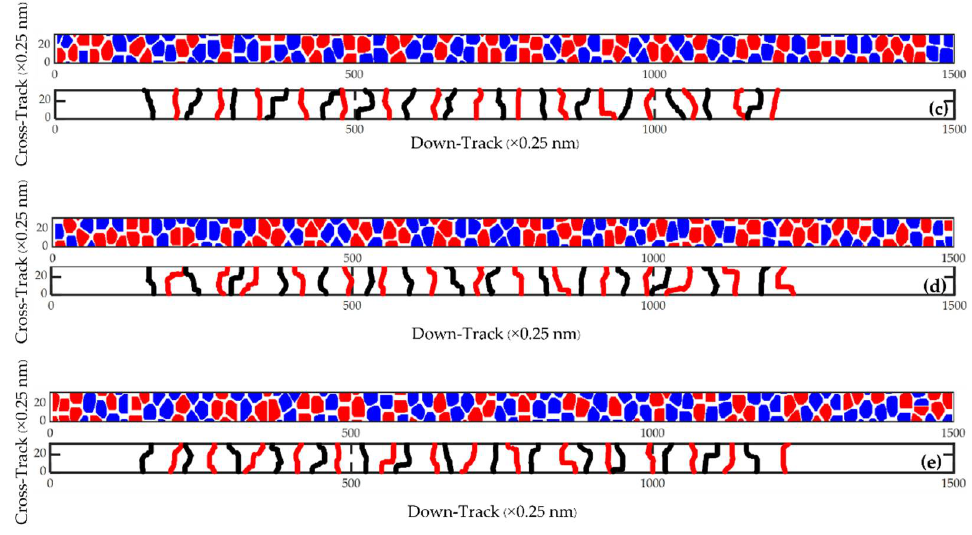
Figure 6. The magnetic footprints ( upper ) at a bit length of 9 nm with a track width 8 nm and the boundary between bits ( lower ) of the ( a ) 1st, ( b ) 2nd, ( c ) 3rd, ( d ) 4th, and ( e ) 5th tracks.